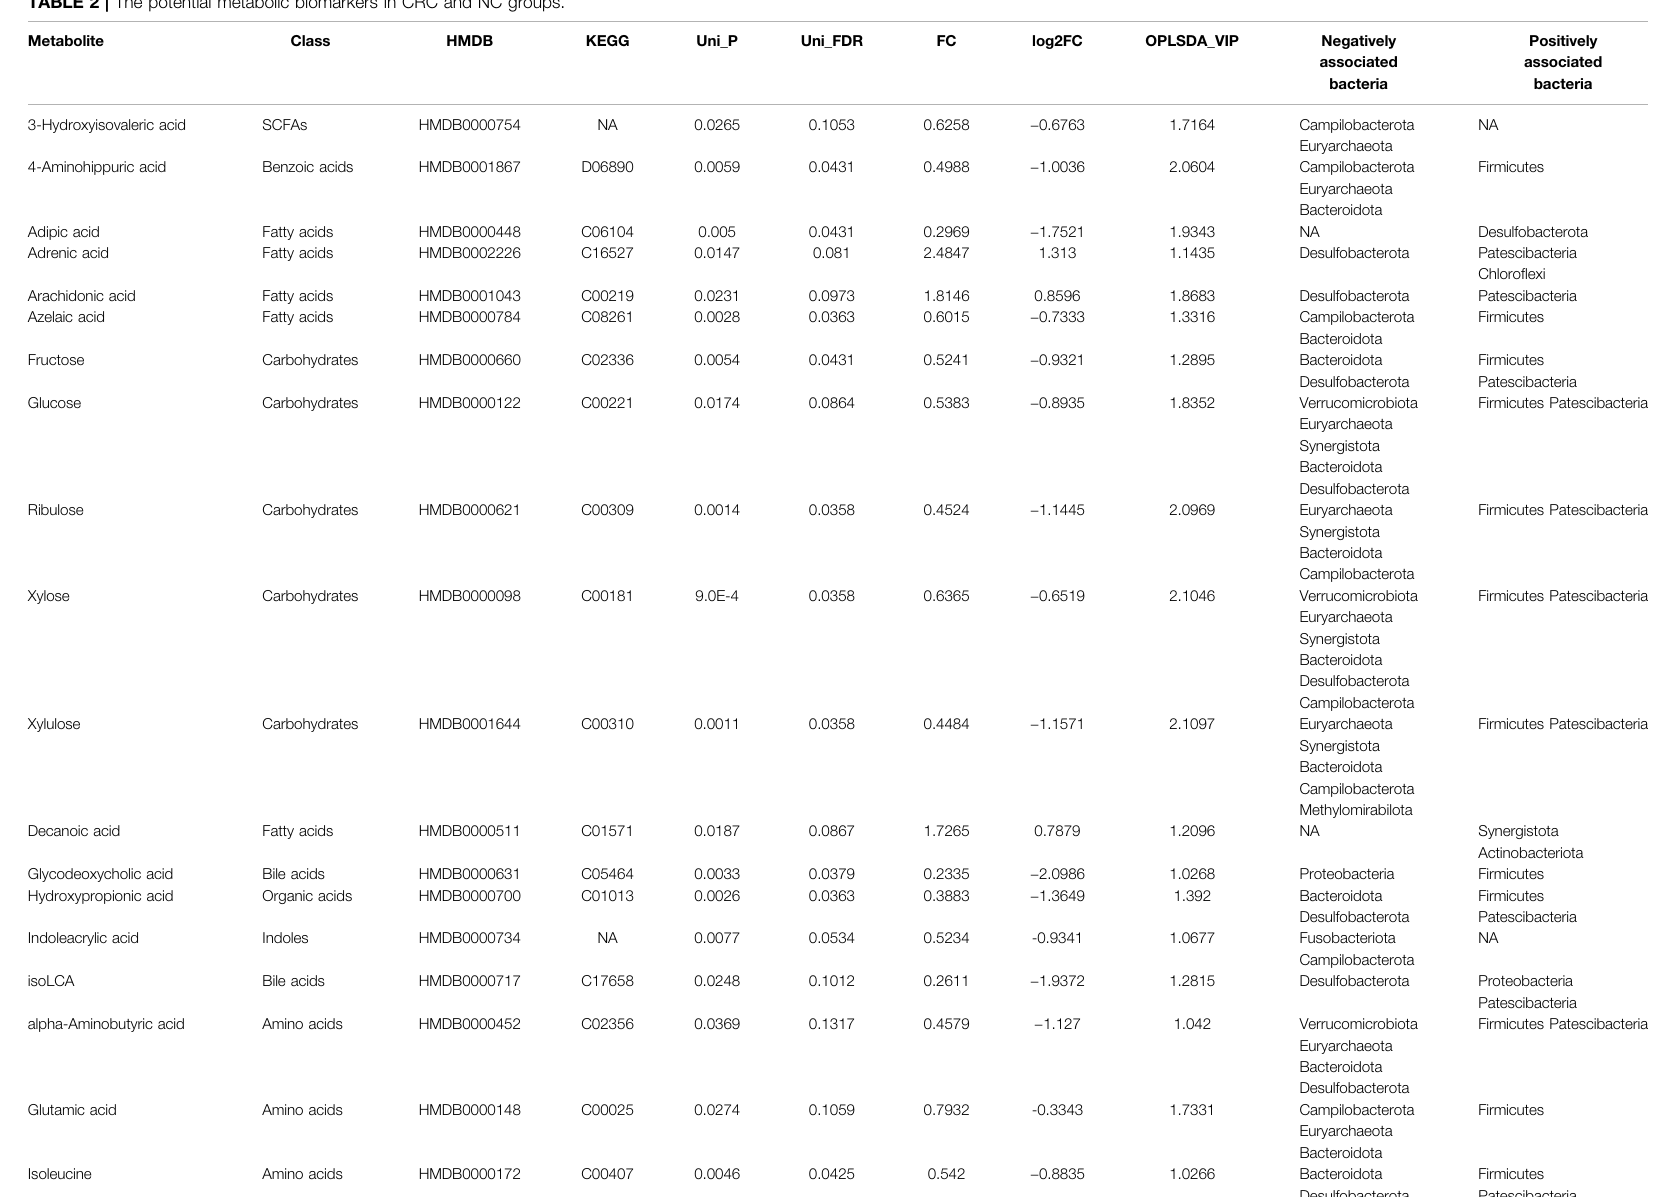
TABLE 2 | The potential metabolic biomarkers in CRC and NC